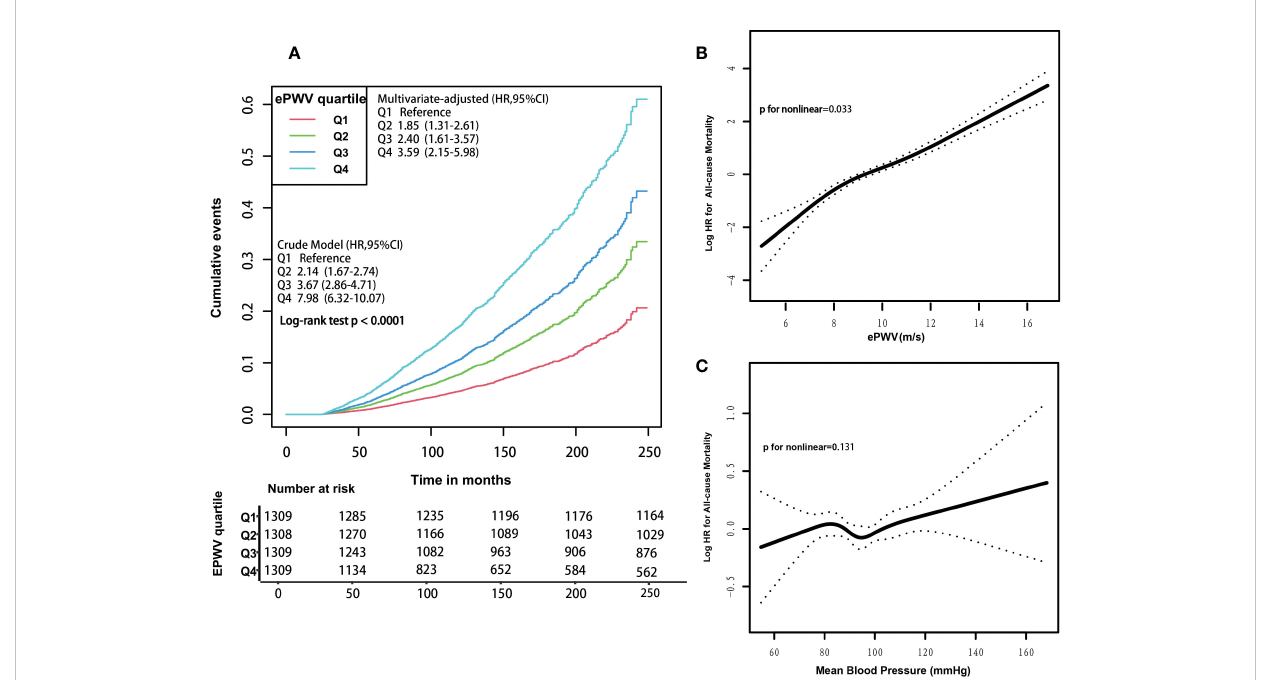
FIGURE 2 (A) Kaplan-Meier survival curves for all-cause mortality, according to ePWV quartile levels. Participants ’ ePWV levels were grouped into quartiles, and crude and multivariate-adjusted model results were expressed as HRs and 95% CIs. Multivariate-adjusted model adjusted for the following